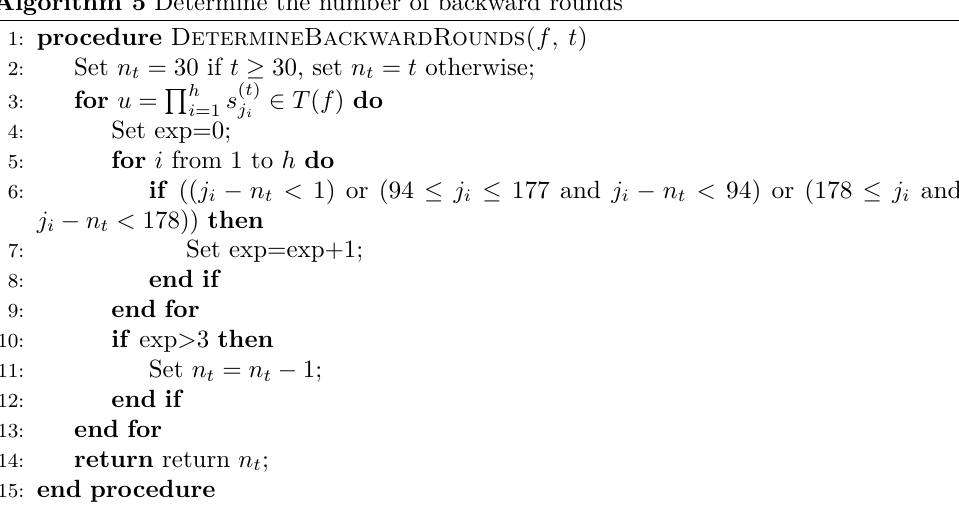
Algorithm 5 Determine the number of backward rounds